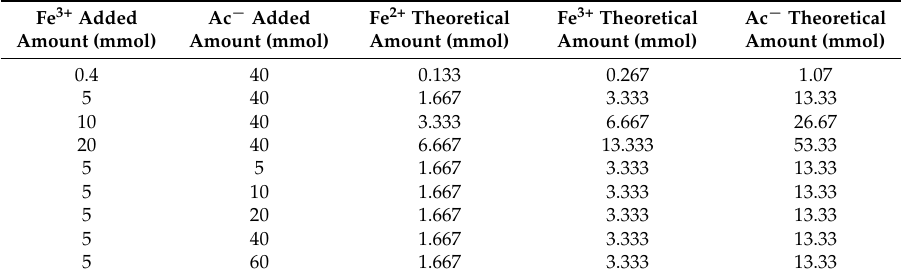
Table 2. The comparison of the theoretical amount and the practical amount of samples in specific experimental